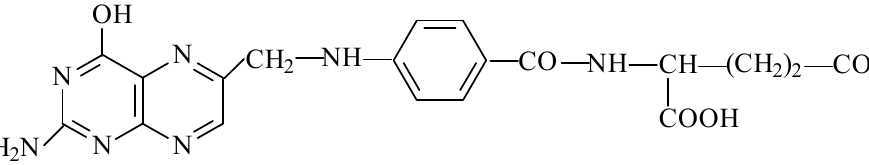
Figure 1. Folic acid (FA) chemical structure.